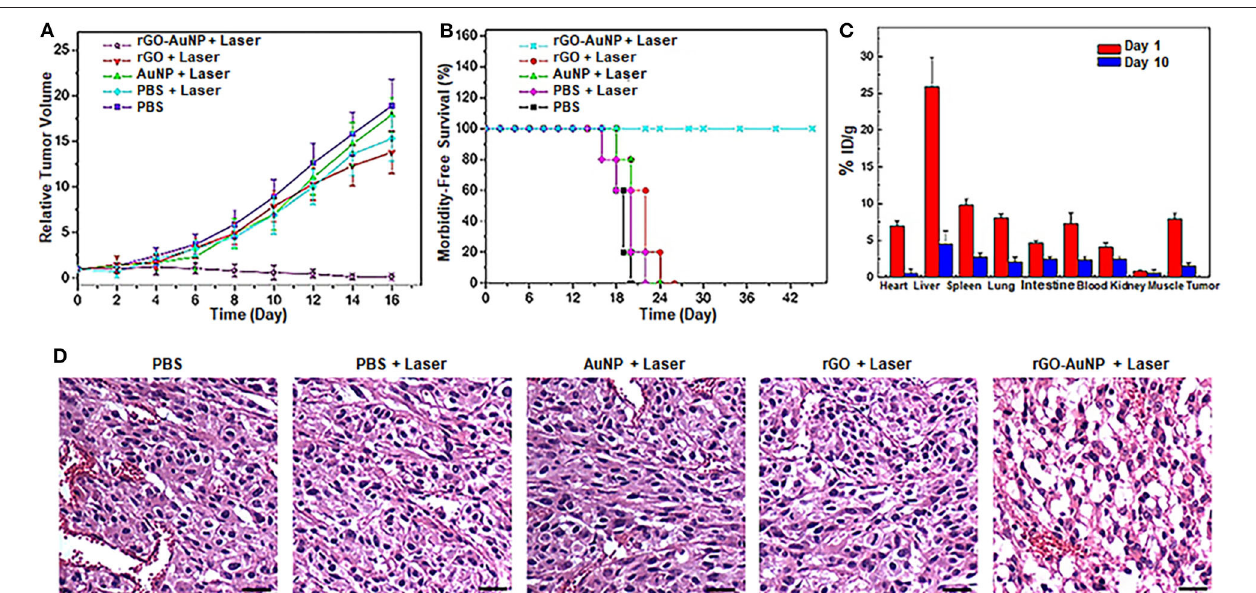
FIGURE 5 | In vivo photothermal therapy. (A) Relative SKOV-3 tumor volume after various treatments. Tumor volumes were normalized to their initial sizes. (B) Survival curves of the SKOV-3-tumor bearing mice after various treatments. (C) Biodistribution of the rGO-AuNP in tumor and different organs at day 1 and day 10 post-injection. (D) Hematoxylin and eosin (H&E) staining images of the tumor sections treated with different samples. The scale bar is 50 µ